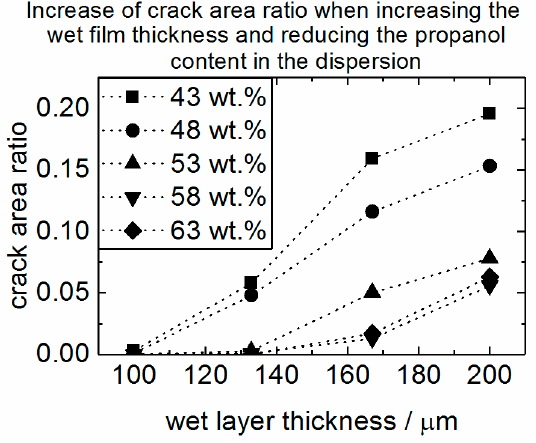
Figure 3. Crack area ratio of all 20 layers produced as a function of wet layer thickness.